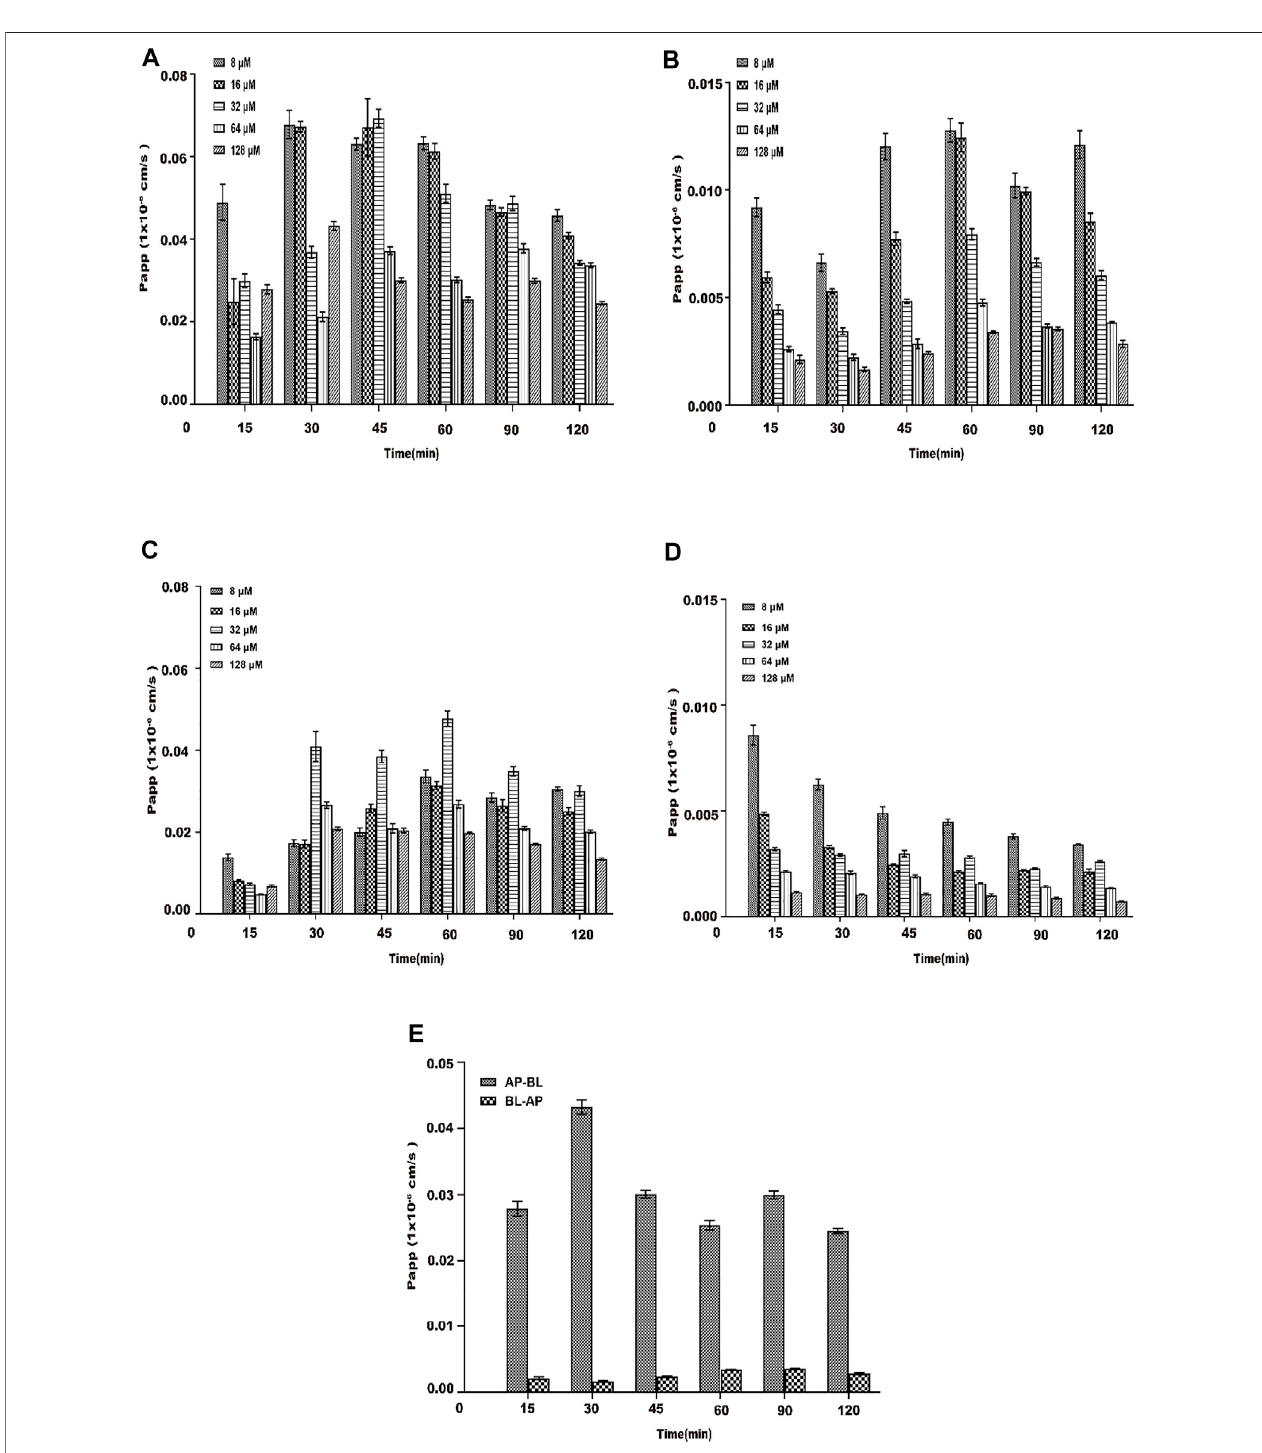
FIGURE7| Pappofeachconcentration(8~128 μ M)ofAEEduring120 min.ThemainactivemetaboliteofAEEassalicylicacidrepresentedforAEEwasquanti fi ed after administration. (A) FromtheAPsidetoBLsideat 37 ° C. (B) FromtheBL sidetoAPsideat37 ° C. (C) FromtheAPsidetoBLsideat4 ° C. (D) FromtheBL sidetoAP side at 4 ° C. (E) AP-BL than BL-AP (64 μ M) at 37 ° C. Values are presented as the means ± SD where applicable ( n = 6). * p < 0.05 than the BL side.